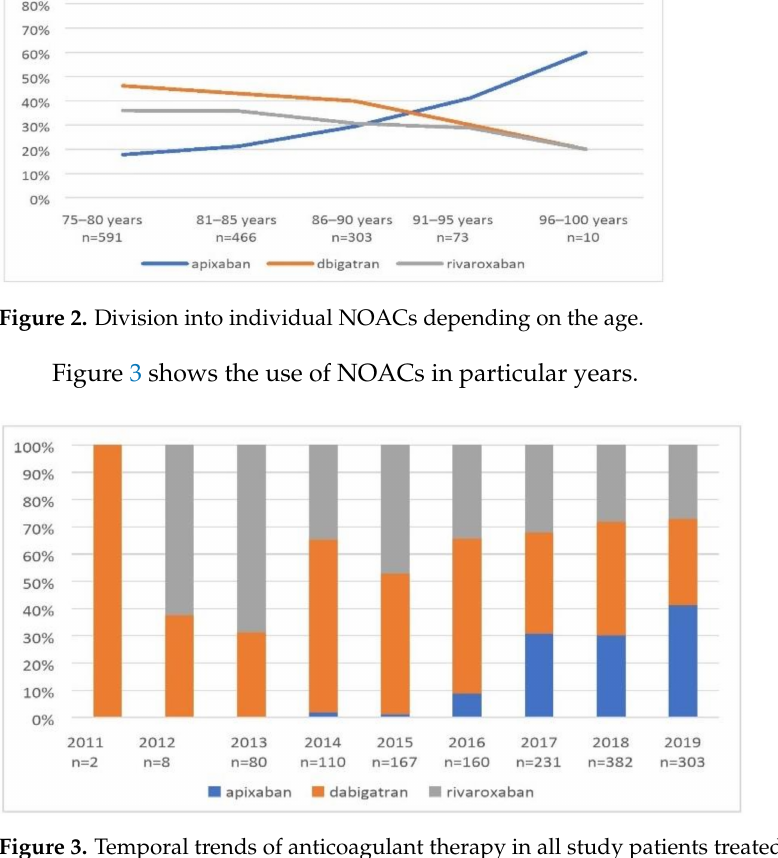
Figure 3. Temporal trends of anticoagulant therapy in all study patients treated with NOACs. The most common comorbidities in the study population were: arterial hyperten- sion —1174 (81.3%) patients, heart failure—992 (68.7%) patients, vascular disease—693 (48%) patients and diabetes—439 (30.4%) patients. The mean CHA 2 DS 2 -VASc score was 5.2 ± 1.4 points. Figure 4 shows the division into individual NOACs depending on the score in the CHA 2 DS 2 -VASc score.